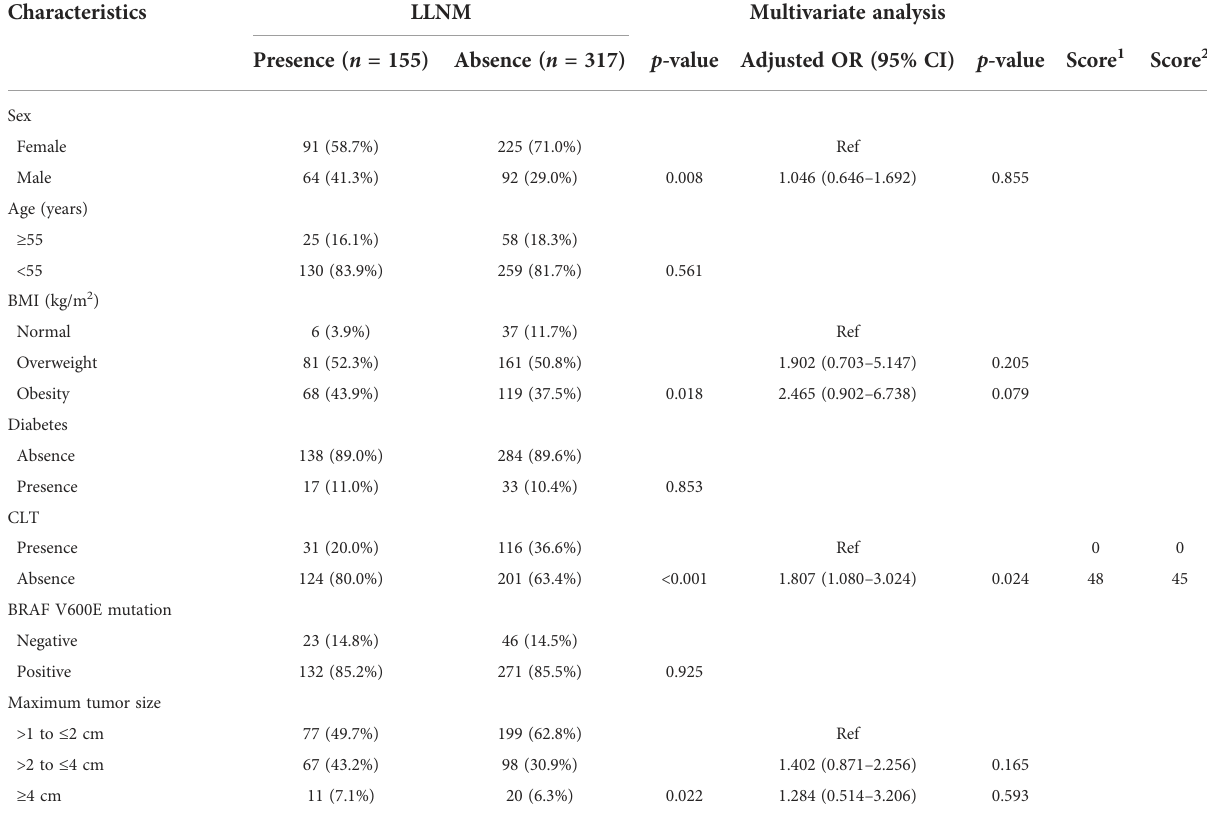
TABLE 4 Univariate analysis and multivariate analysis of factors associated with LLNM in patients with macro-PTC.